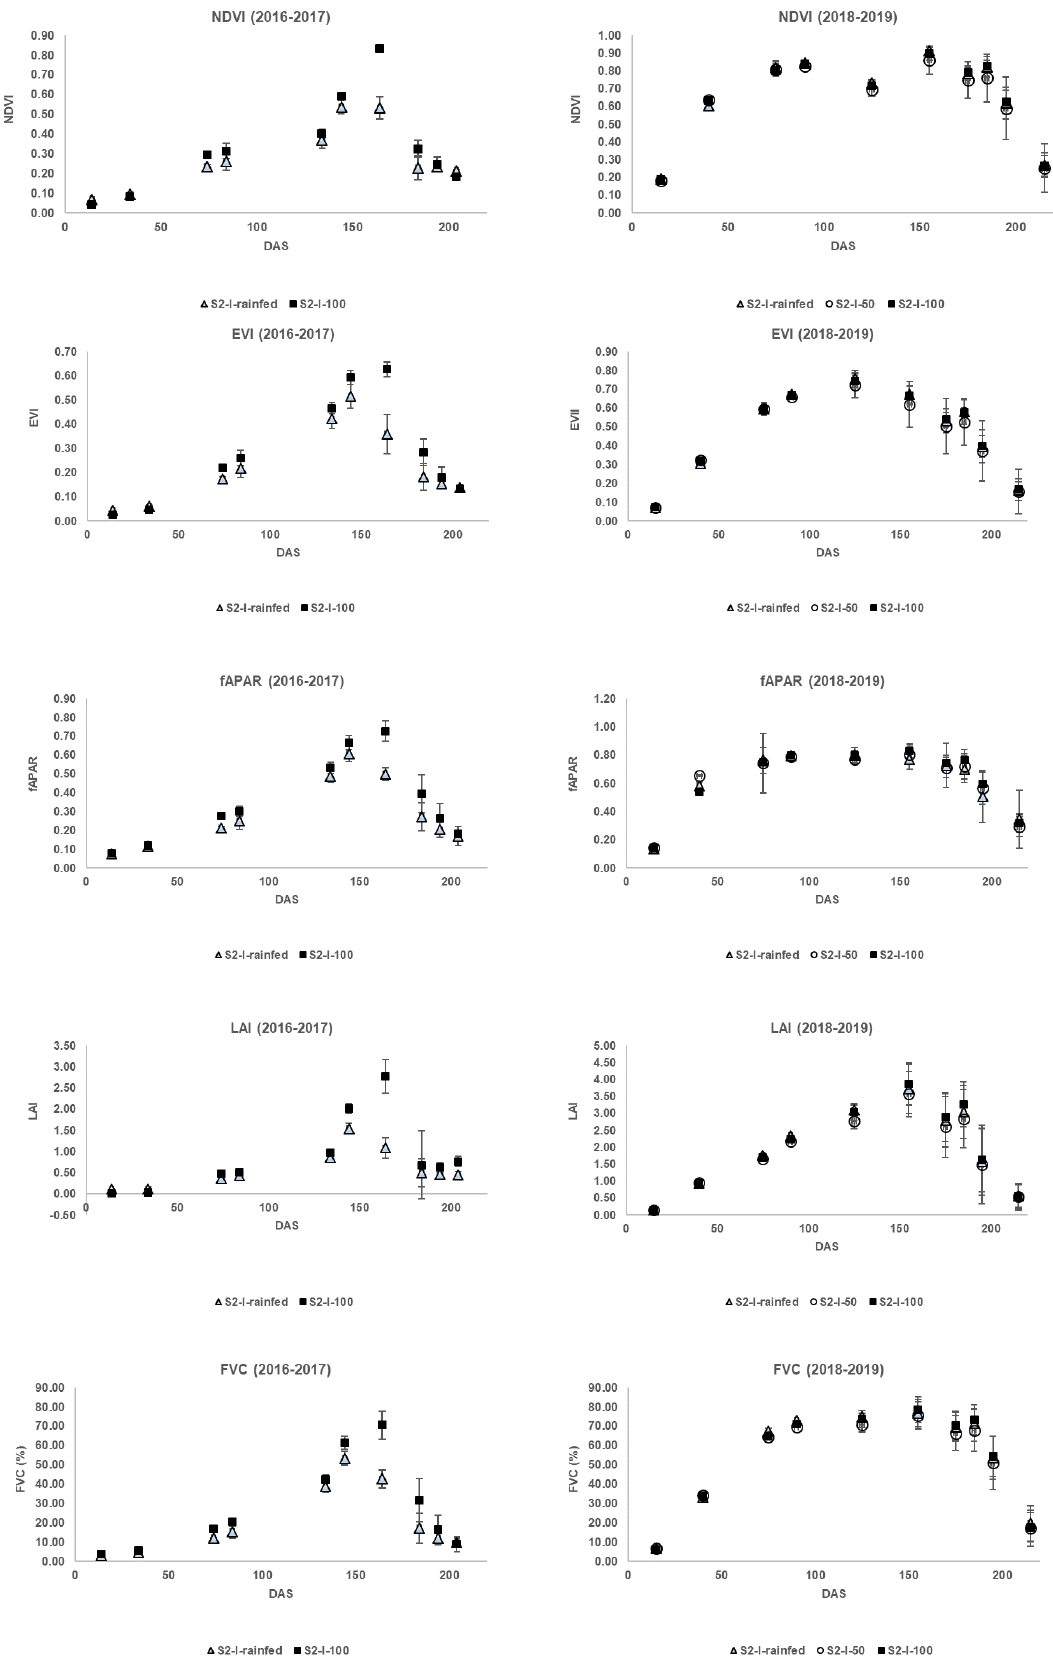
Figure 1. Trends of S2-derived vegetation indices for the growing seasons 2016–2017 and 2018–2019. Regressions were fitted to relate biomass with S2 vegetation indices. Table 2 reports these relationships. The lowest and highest R2 values (0.12 and 0.85) were found for EVI and FVC, respectively. In descending order of R2, the indices were ranked FVC, LAI, fAPAR, NDVI and EVI. The use of EVI for monitoring long-term change of crops is de- bated. For example, [36] reported that this index presented some weakness compared to other vegetation indices; however [24] obtained satisfactory results for predicting yield and biomass production. Three R2 values were above 0.70, one above 0.40, and one below 0.40. All simulated Sentinel-2 vegetation indices were fitted to power regression (Table 2). The results showed that biomass was associated with the vegetation indices. Particularly, FVC and LAI were highly correlated with biomass. Such findings agree with the study of [37], who found that LAI was highly correlated to maize biomass. The same was men- tioned in the experiment implemented for the winter wheat crop by [21] where LAI